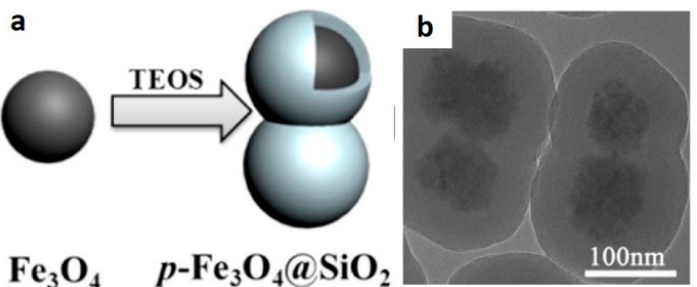
Figure 8. Schematic illustration of the fabrication process of short peapod-like magnetic nanochains. ( a ) Schematic synthesis protocol and ( b ) TEM image of the resulting nanochains. Reprinted with permission from [106], Copyright © 2021, with pemission from American Chemical Society.